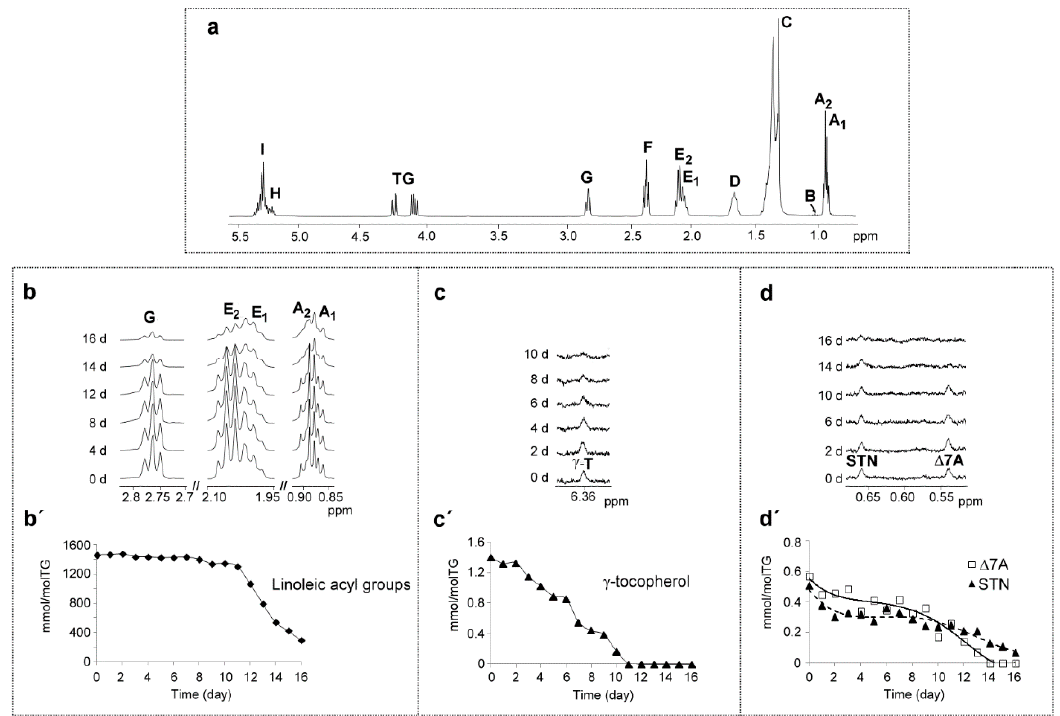
Figure 1. ( a ) Region between 0.5 and 5.5 ppm of corn oil, C, 1 H NMR spectrum. Spectral regions, conveniently enlarged, of the signals of ( b ) methylic, mono -allylic and bis -allylic; ( c ) gamma -tocopherol ( γ -T); ( d ) Δ 7-avenasterol ( Δ 7A) and sitostanol (STN). The signal letters agree with those of Table S1 of Supplementary Material. Evolution of the concentration, expressed as mmol/mol TG, present in corn oil submitted to oxidation process versus time given in days of ( b’ ) linoleic acyl groups, ( c´ ) gamma -tocopherol ( γ -T), ( d´ ) Δ 7-avenasterol ( Δ 7A) and sitostanol (STN).